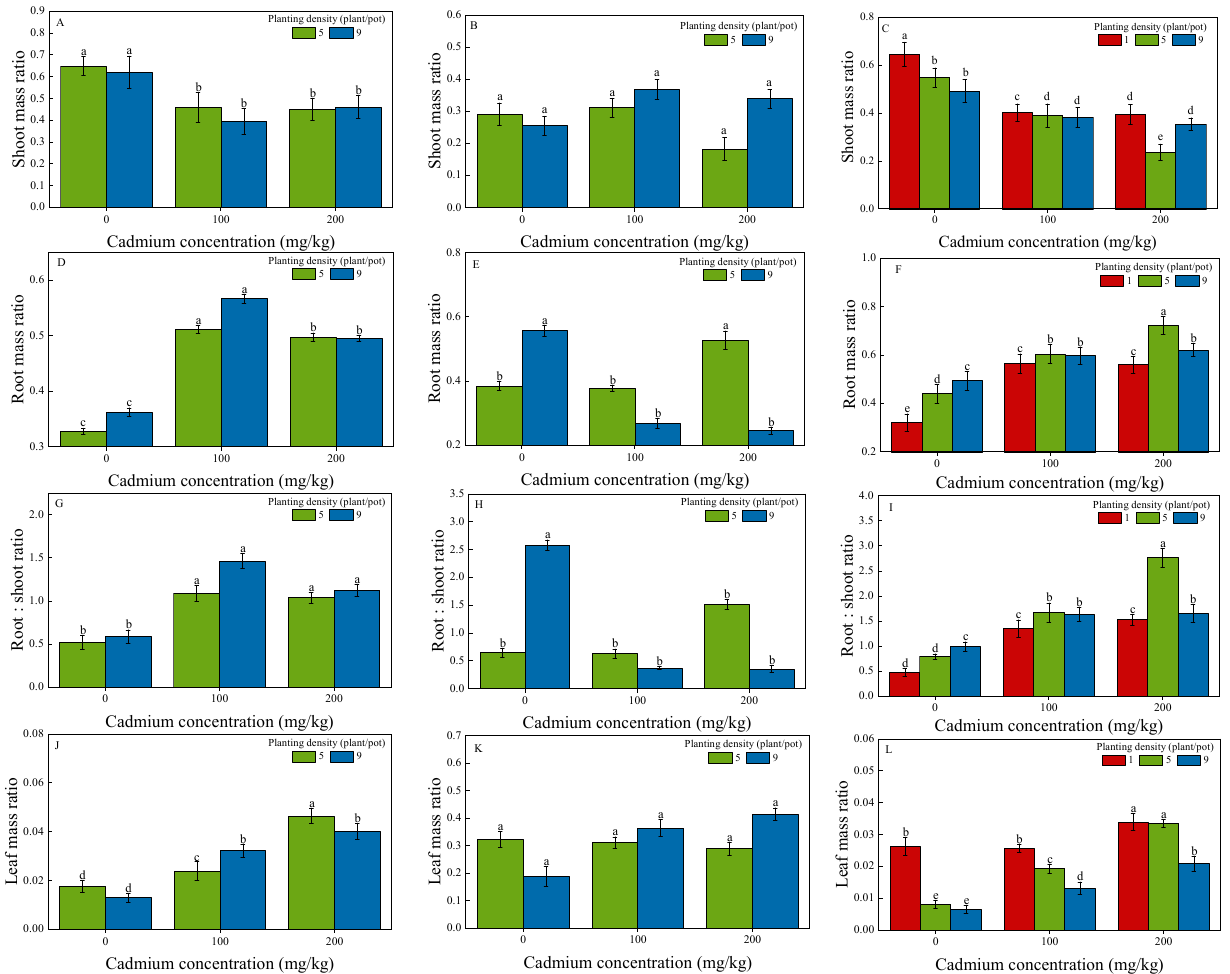
Figure 2. Biomass allocation of A. philoxeroides and T. regens in monoculture and mixed culture. ( A , D , G , J ), ( B , E , H , K ), and ( C , F , I , L ) were the biomass allocation of A. philoxeroides in mixed culture, the biomass allocation of T. regens in mixed culture, and the biomass allocation of A. philoxeroides in monoculture, respectively. Lowercase letters indicate a significant difference ( p < 0.05) in A. philoxeroides or T. regens present on each treatment based on post hoc multiple comparisons in Duncan with cadmium concentration and planting density as fixed